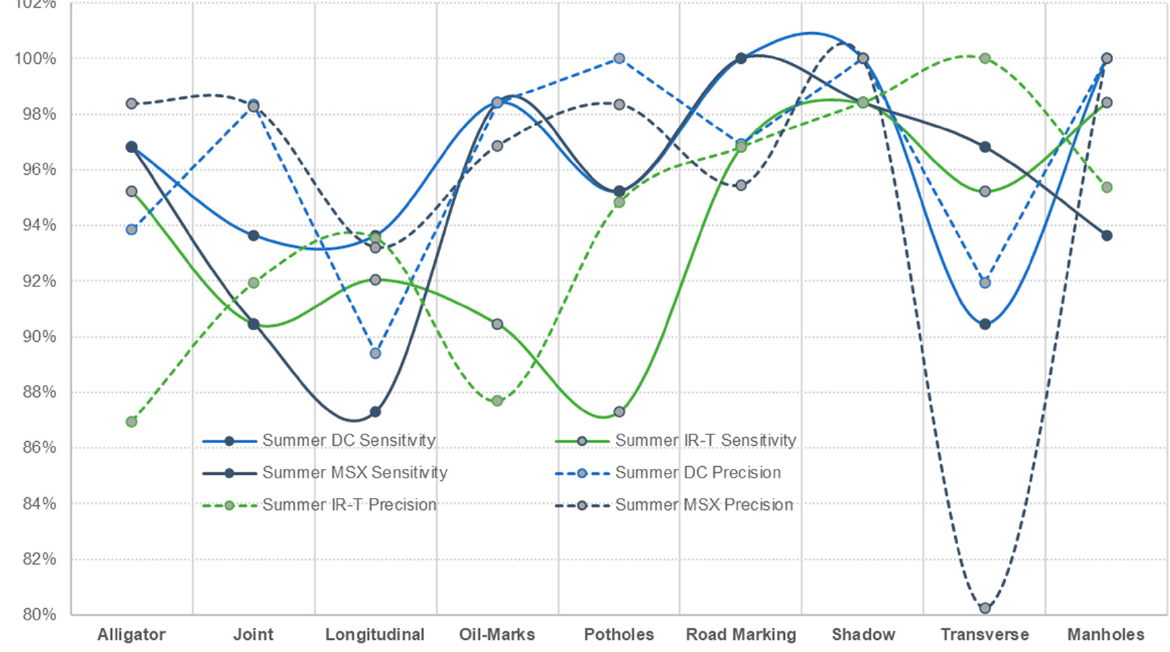
Figure 13. Summer conditions—sensitivity and precision.